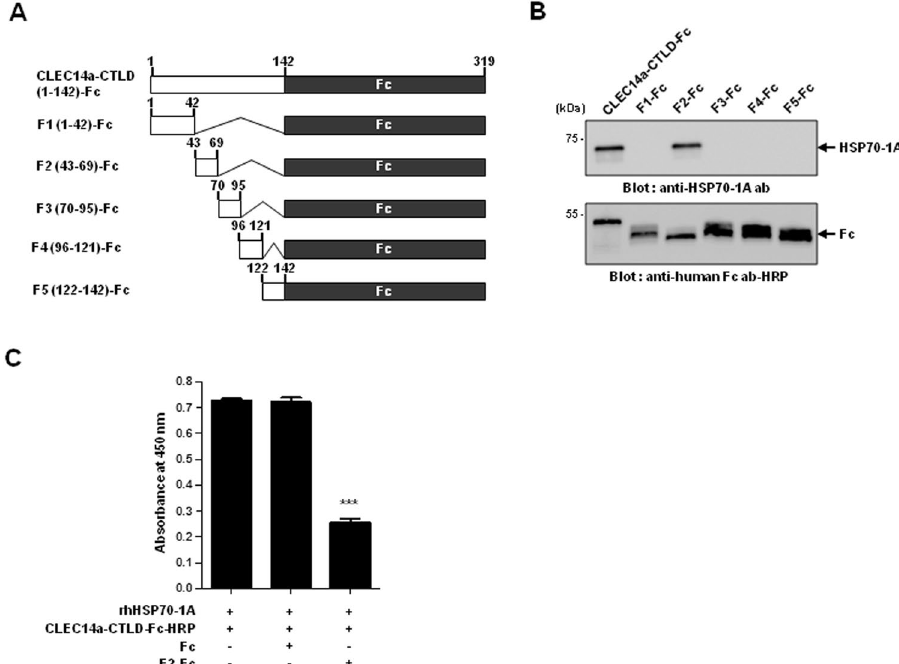
Figure 4. Determination of the HSP70-1A-interacting region of CLEC14a-CTLD. ( A ) Schematic representation of Fc fusion proteins, including CLEC14a-CTLD (amino acids 1–142) and its fragments, F1 HSP70-1A (upper panel) and human Fc (lower panel). The results shown are representative of two separate experiments. ( C ) The binding of the CLEC14a-CTLD-Fc-HRP to rhHSP70-1A was measured by ELISA in the absence or presence of F2-Fc or Fc, as indicated. Data are represented as the mean ± SEM of triplicate measurements from two independent experiments; *** P <